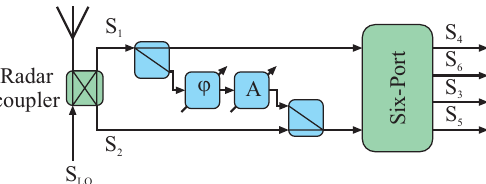
Figure 6. Offset compensation structure (in blue) to enhance the isolation between both six-port input ports.